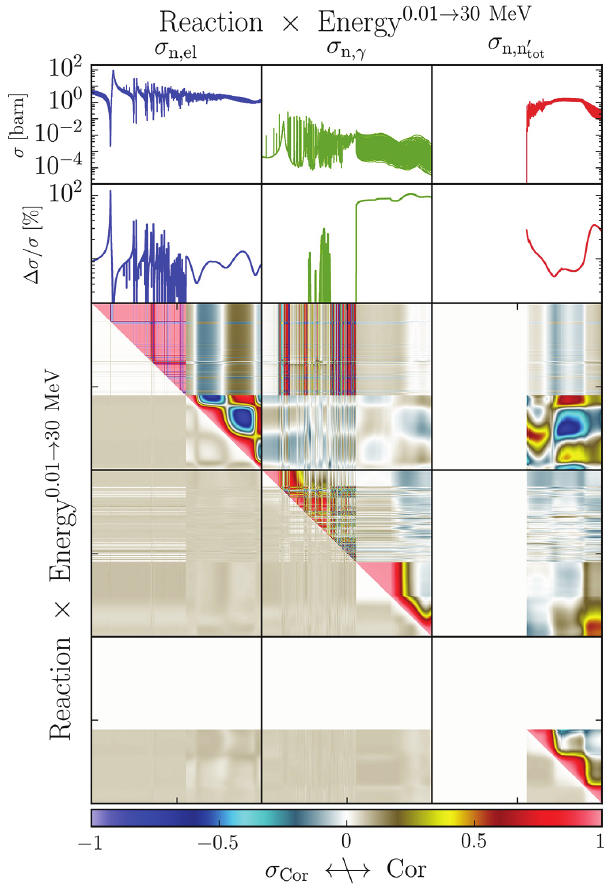
Fig. 1. 56 Fe neutron elastic scattering (left), capture (middle) and inelastic scattering (right) cross-sections from TENDL2017 database [6], 256 random ACE files ( 1 st line), relative uncer- tainty ( 2 nd line) and correlation matrix ( 3 last lines) repre- sented with its standard deviation estimated with a Jackknife resampling technique